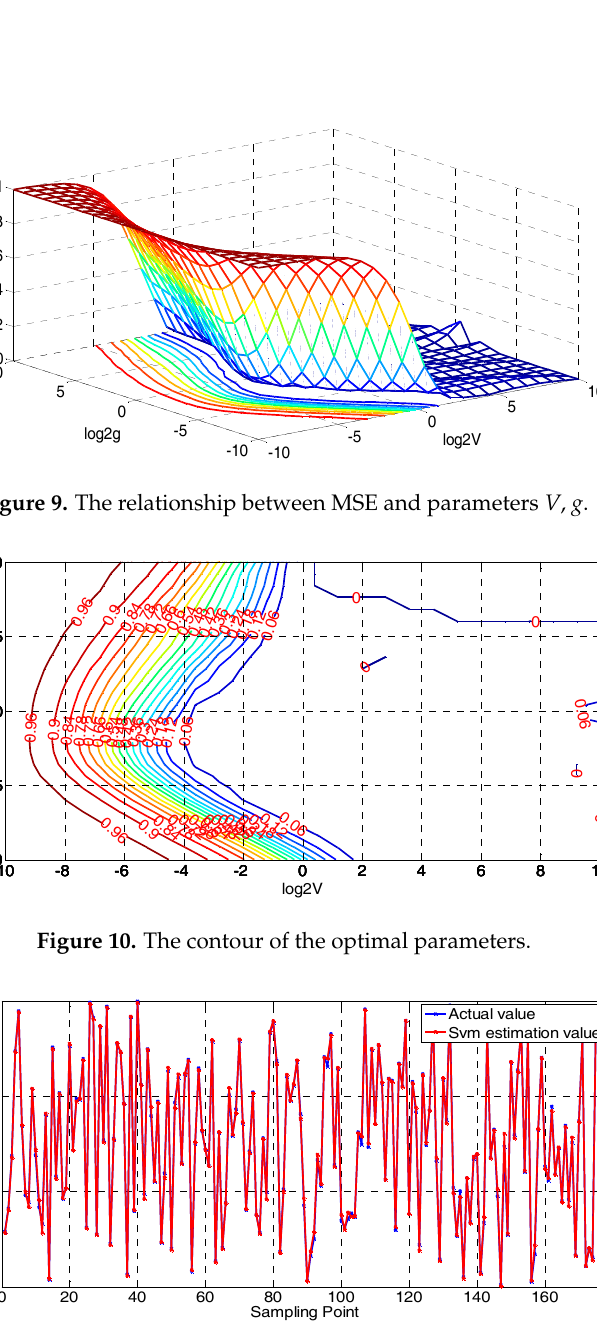
Figure 11. The estimation result of the SVM model.